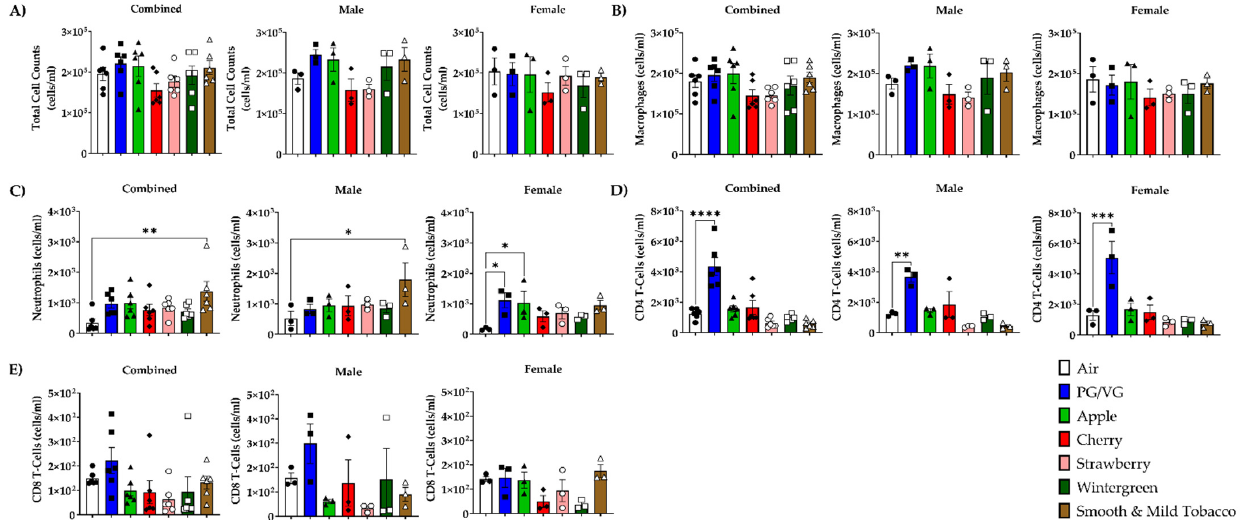
Figure 1. Sex-dependent effects of flavored e-cigarette exposure on inflammatory cell count in bronchoalveolar lavage fluid. Mice were exposed to air, PG/VG, and e-liquid flavors “Apple”, “Cherry”, “Strawberry”, “Wintergreen”, and “Smooth & Mild Tobacco” for 3 days for 1 h per day. Mice were sacrificed twenty-four hours after the final exposure. (A) Total cell counts were obtained by staining cells with AO/PI and counting with a cellometer. Differential cells were measured using flow cytometry: (B) F4/80+ macrophages, (C) Ly6 B.2+ neutrophils, (D) CD4+ T-cells, and (E) CD8+ T-cells. Data are shown as mean ± SEM with individual data points represented by the following symbols: Air (black circles), PG/VG (black squares), Apple (black triangles), Cherry (black diamonds), Strawberry (white circles), Wintergreen (white squares), Smooth & Mild Tobacco (white triangles), with * indicating p < 0.05, ** p < 0.01, *** p < 0.001, and **** p < 0.0001 vs. air controls. n = 6 for combined groups and n = 3 for male- and female-only groups.